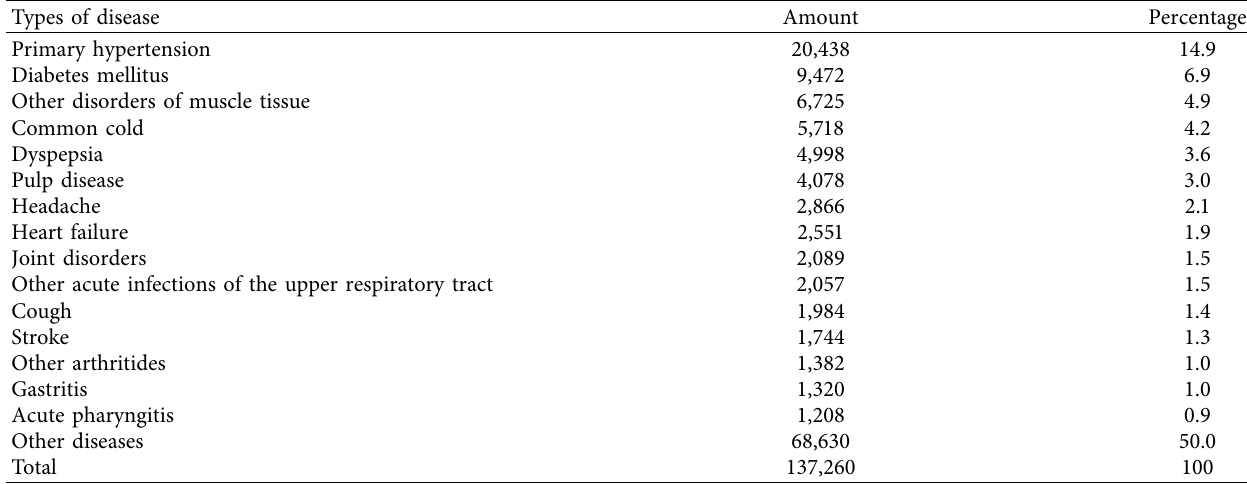
Table 1: Types of diseases suffered by the elderly in Sleman,